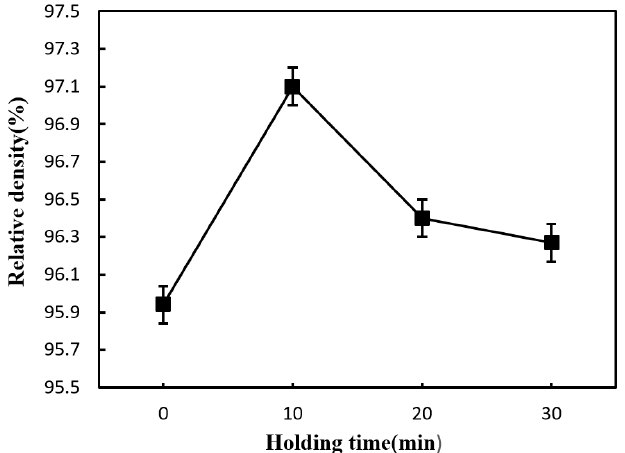
Figure 8. E ff ect of holding time on the relative density of the sintered Si 3 N 4 / n-SiC ceramic at 1600 ◦ Figure 8. Effect of holding time on the relative density of the sintered Si 3 N 4 /n-SiC ceramic at 1600 °C.